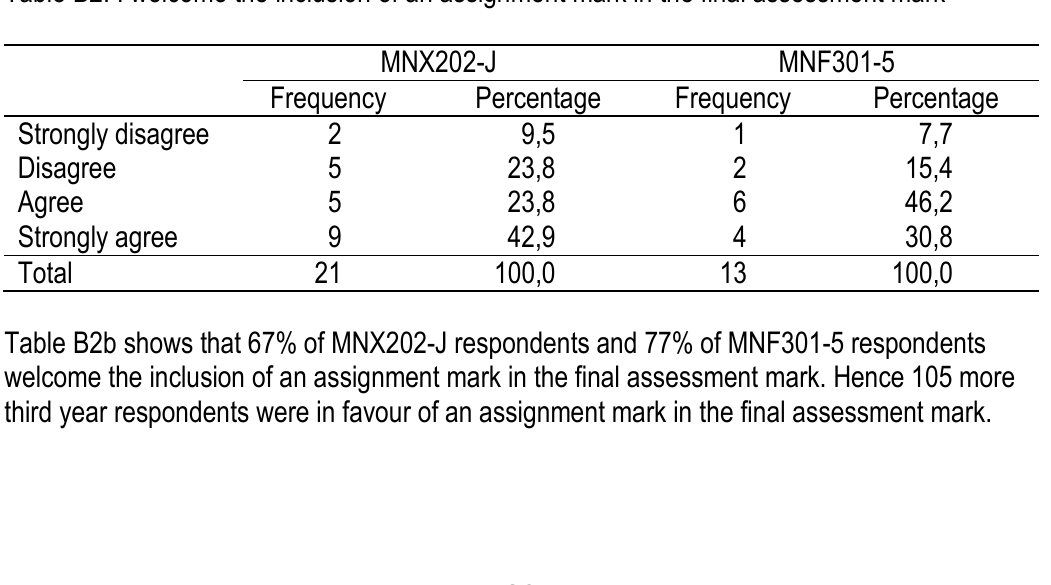
Table B2: I welcome the inclusion of an assignment mark in the final assessment